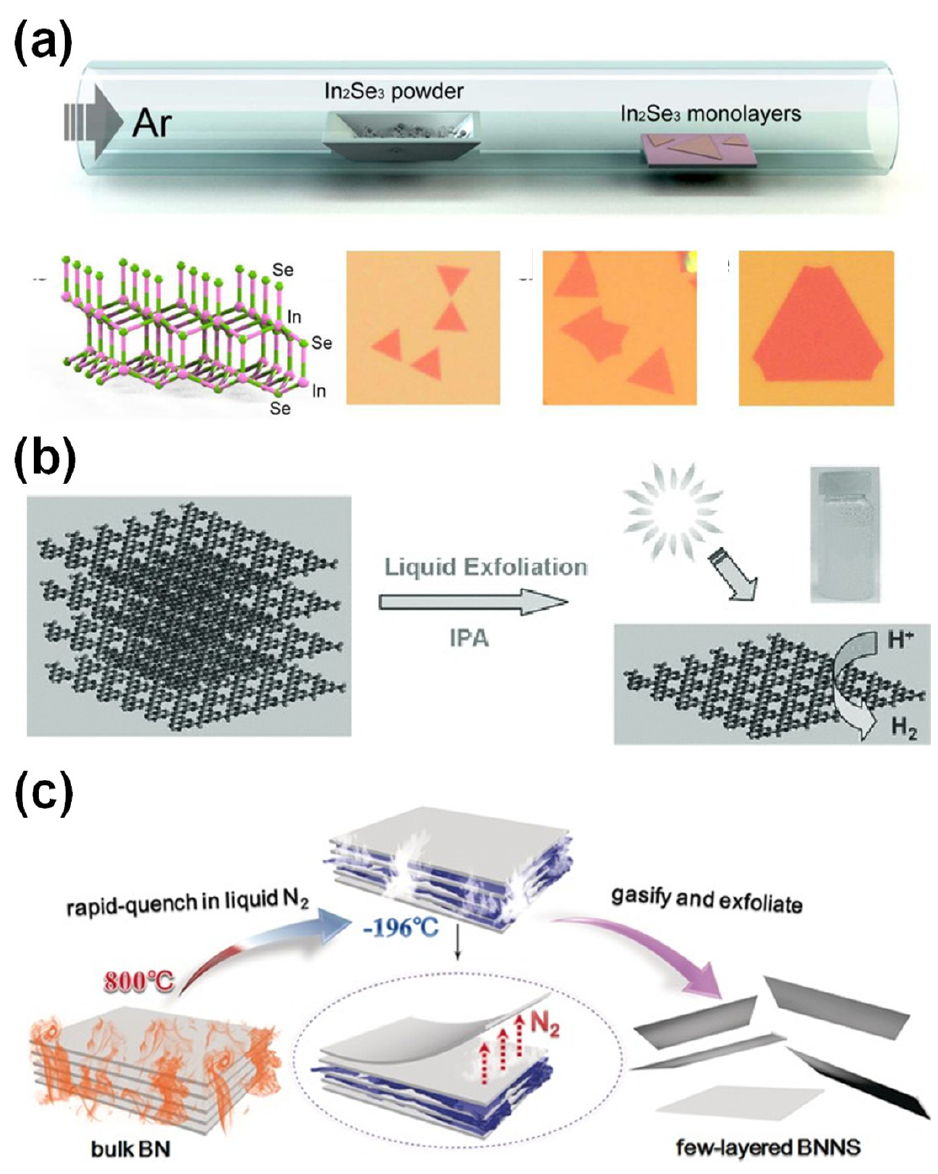
Figure 2. Several top-down approaches for the synthesis of 2D ultrathin nanomaterials: ( a ) Growth of atomic layered In 2 Se 3 via a PVD method and the corresponding optical images [22]. Copyright 2015, American Chemical Society; ( b ) Synthesis of g-C 3 N 4 ultrathin nanosheets via liquid phase exfoliation from bulk g-C 3 N 4 [27]. Copyright 2013, Wiley-VCH; ( c ) Gas exfoliation of hexagonal boron nitride ultrathin nanosheets triggered by thermal expansion [28]. Copyright 2016,